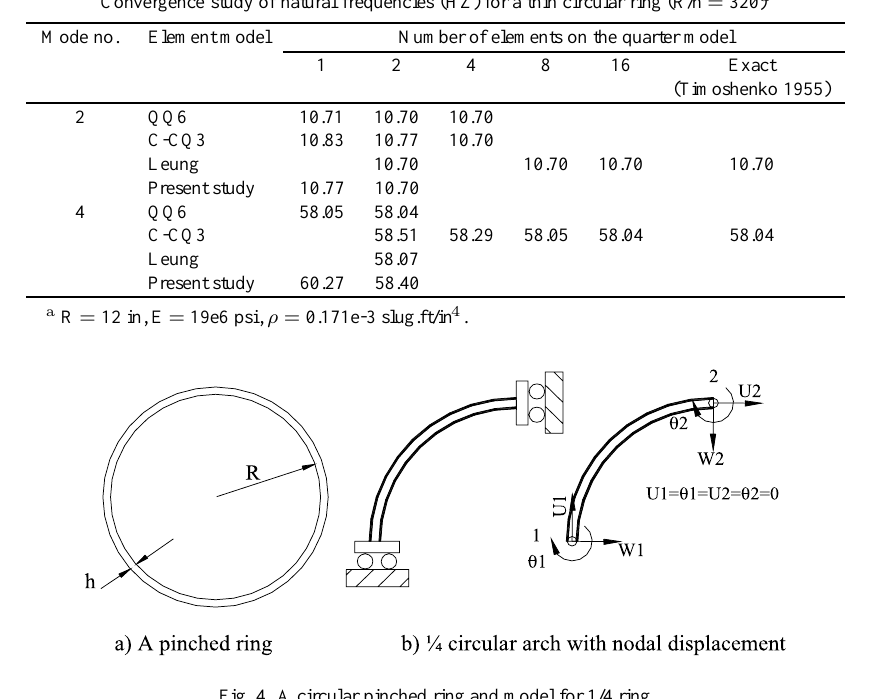
Table 2 Convergence study of natural frequencies (HZ) for a thin circular ring (R/h = 320) a